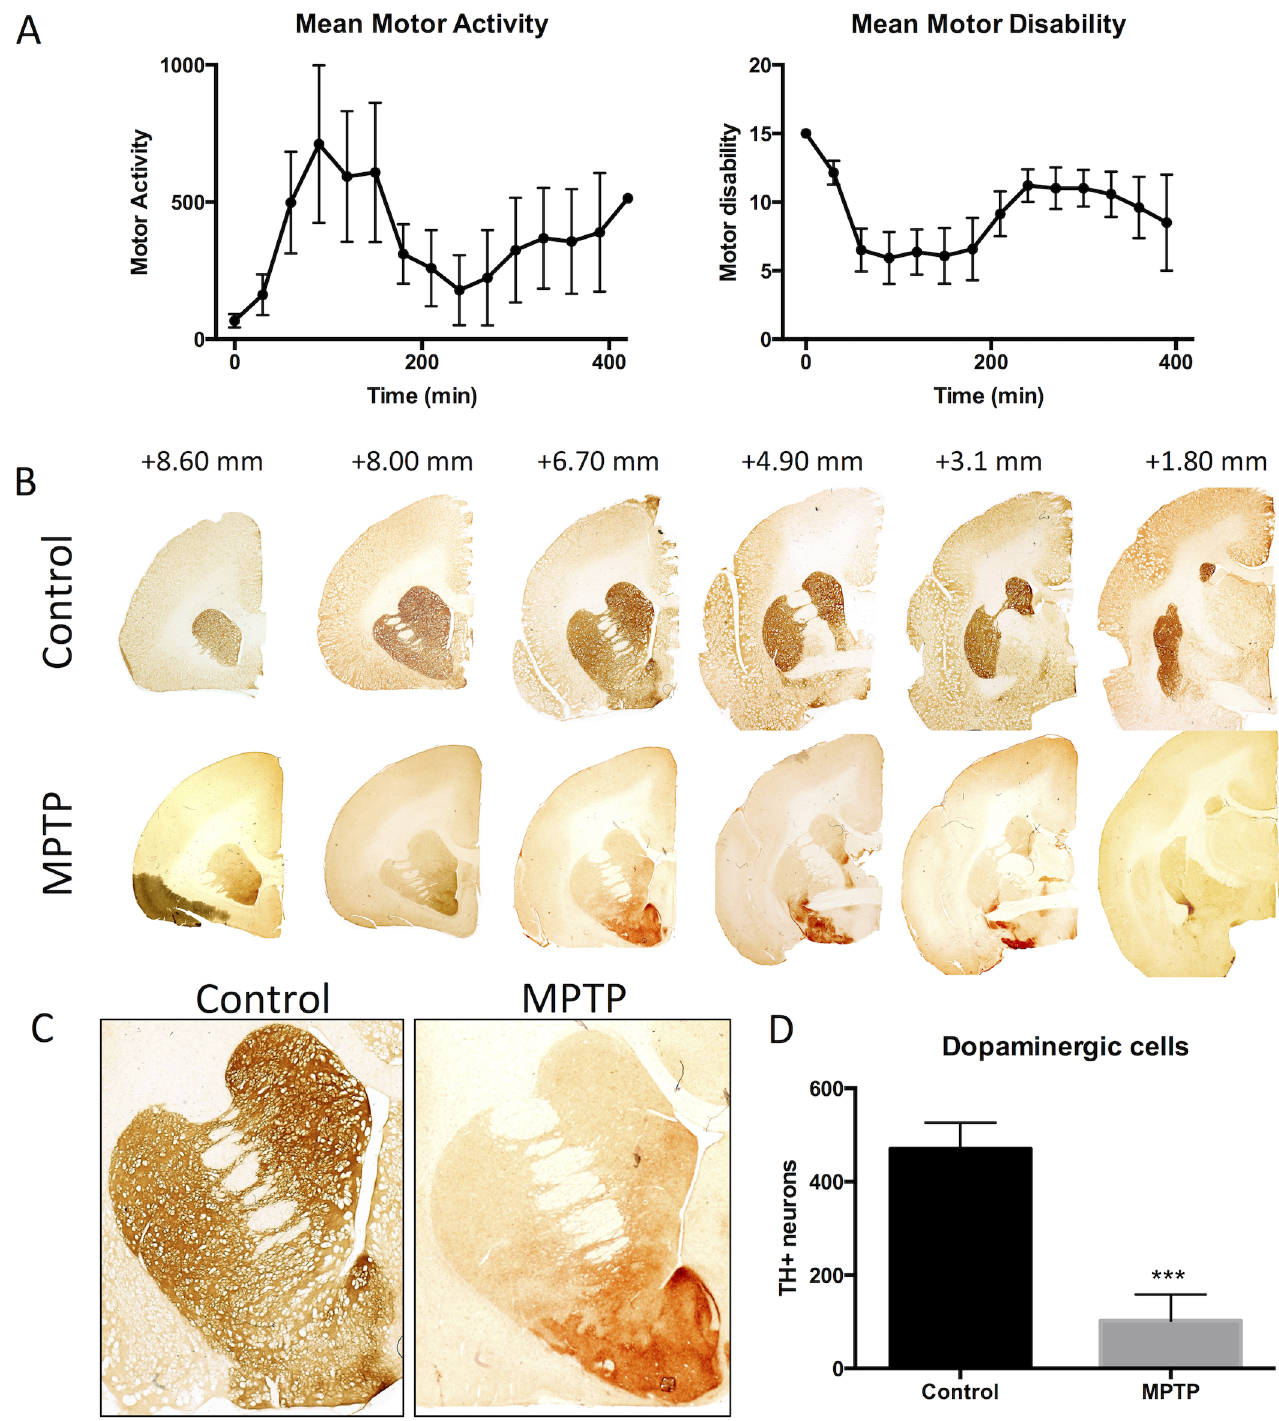
Fig 3. Motor performance and loss of dopaminergic innervation of the nigral-striatal pathway. A. Motor activity and motor disability in MPTP treated common marmoset treated with a single dose of 12.5mg/kg levodopa plus 12.5 mg/kg carbidopa.Administration of levodopa led a marked increasedin motor activity (left panel) and marked reduction in motor disability (right panel). Both motor activity and motor disability peak at around 90 min of levodopaoral administration. Each data point is a mean ± s.e.m, n = 7. B. A denervation of tyrosine hydroxylase (TH) positive dopaminergic fibers is seen in the caudateand putamenafter MPTP administration. C. A highermagnification of the caudate and putamen further highlights the dramatic loss of dopaminergicfibers in both structures with an even loss throughoutthe structure. D. A quantification of TH+ neuronsin the substantianigra further demonstrated a significant(p < 0.001)loss of ~80% of these neuronsdue to MPTP treatment. https://doi.org/10.1371/journal.pone.0180733.g003 PLOS ONE | https://doi.org/10.1371/journal.pone.0180733 July 24,